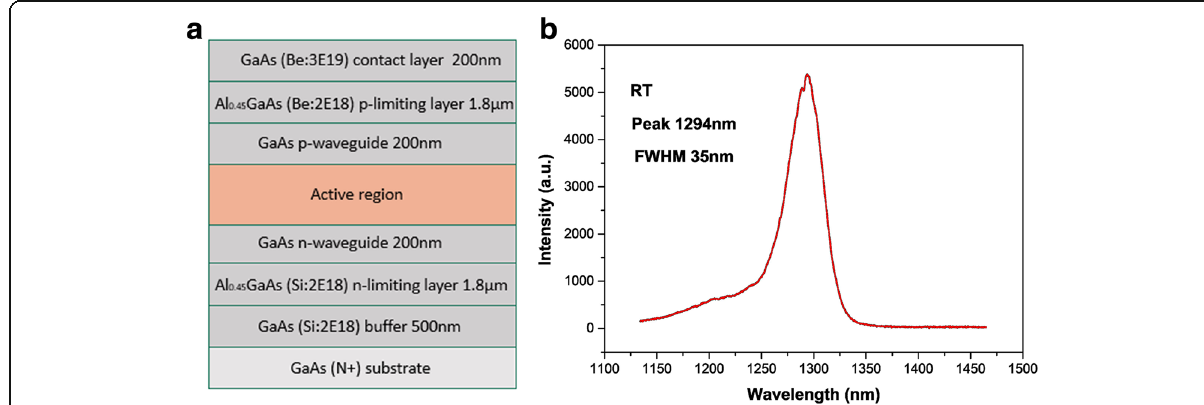
Fig. 4 Device structure. a 1.3- μ m quantum dot F-P broad area laser's epitaxial structure. b PL spectrum of the QDs laser's epitaxial structure at RT. The central wavelength is 1294